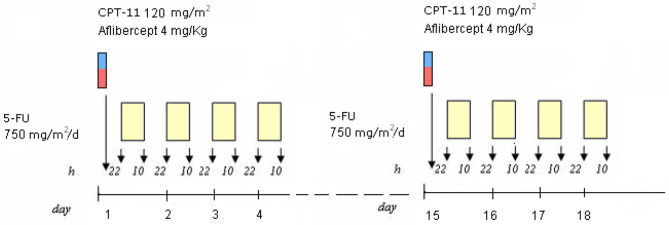
Planned treatment schedule.